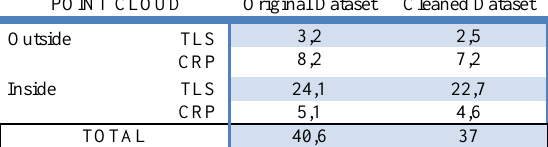
Table 1. Millions of points of the acquired and merged dataset For the generation of the geometrical three-dimensional model, plans and sections derived from existing documents of the Baptistery have been used. In particular, a ground floor plan dating back to the 1906 (Lanckoronski, 1906) has been considered as reference (Figure 6).